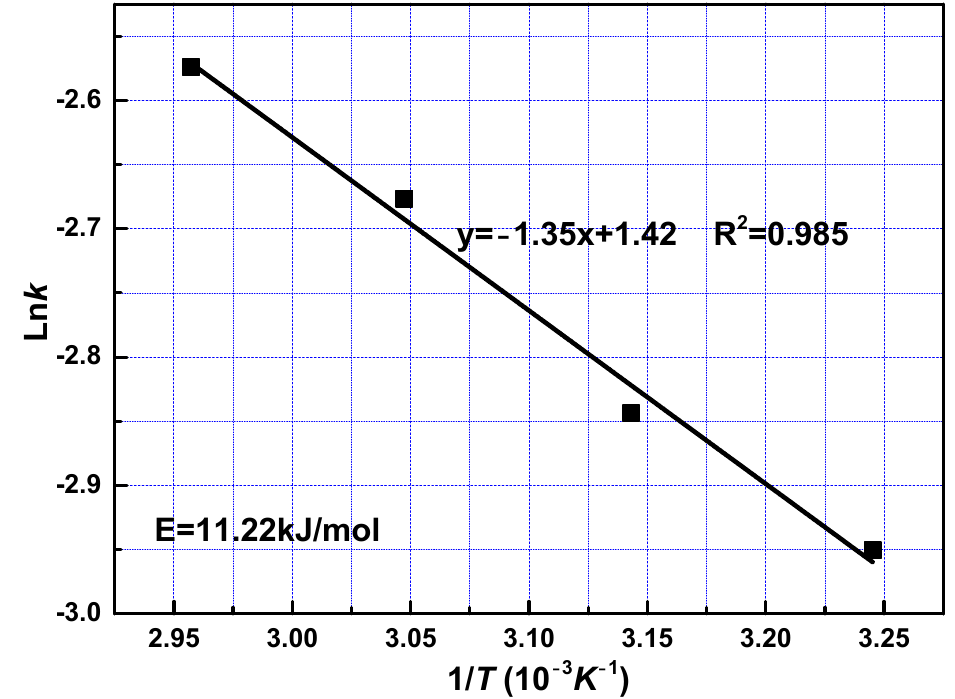
Figure 7. Arrhenius plot for leaching of REEs from phosphate ore at fast reaction stage.